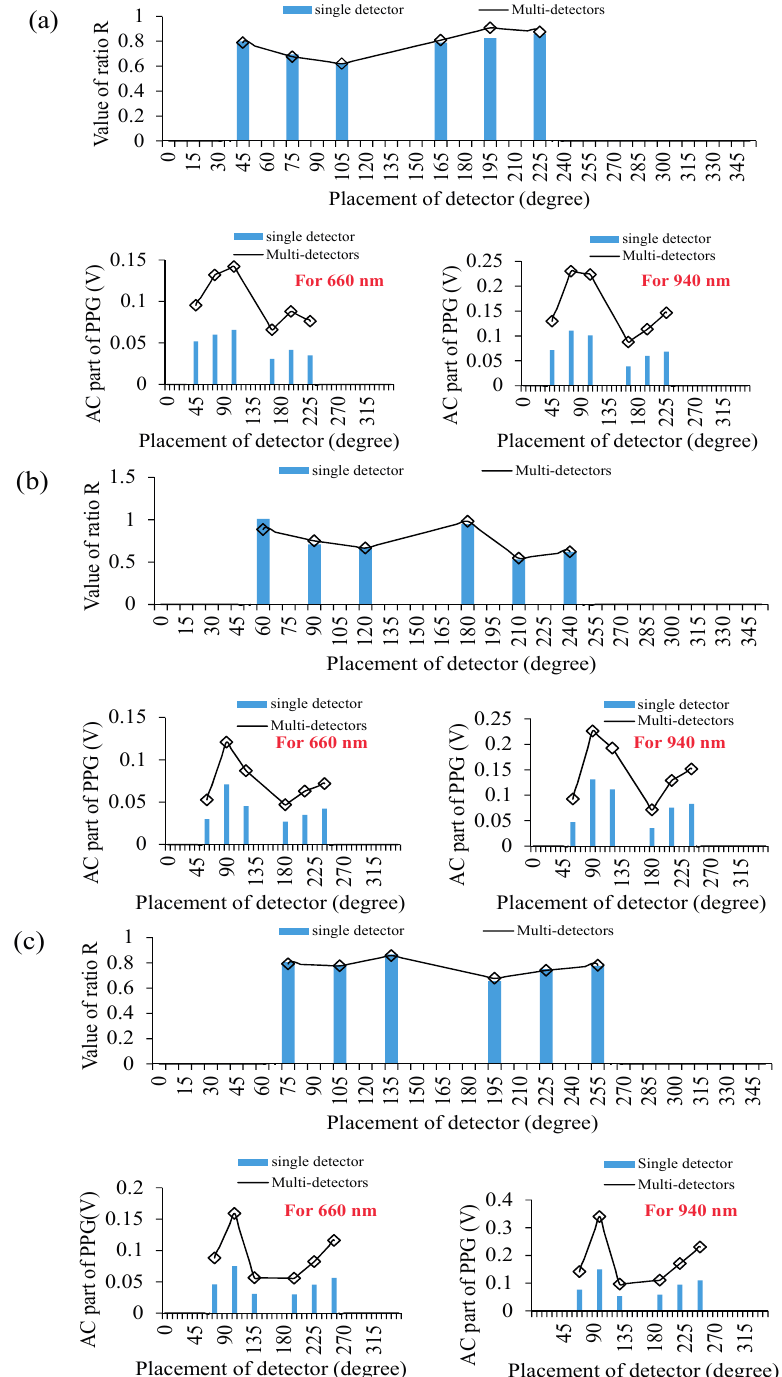
Figure 6. Comparisons of the experimental results for the AC part of